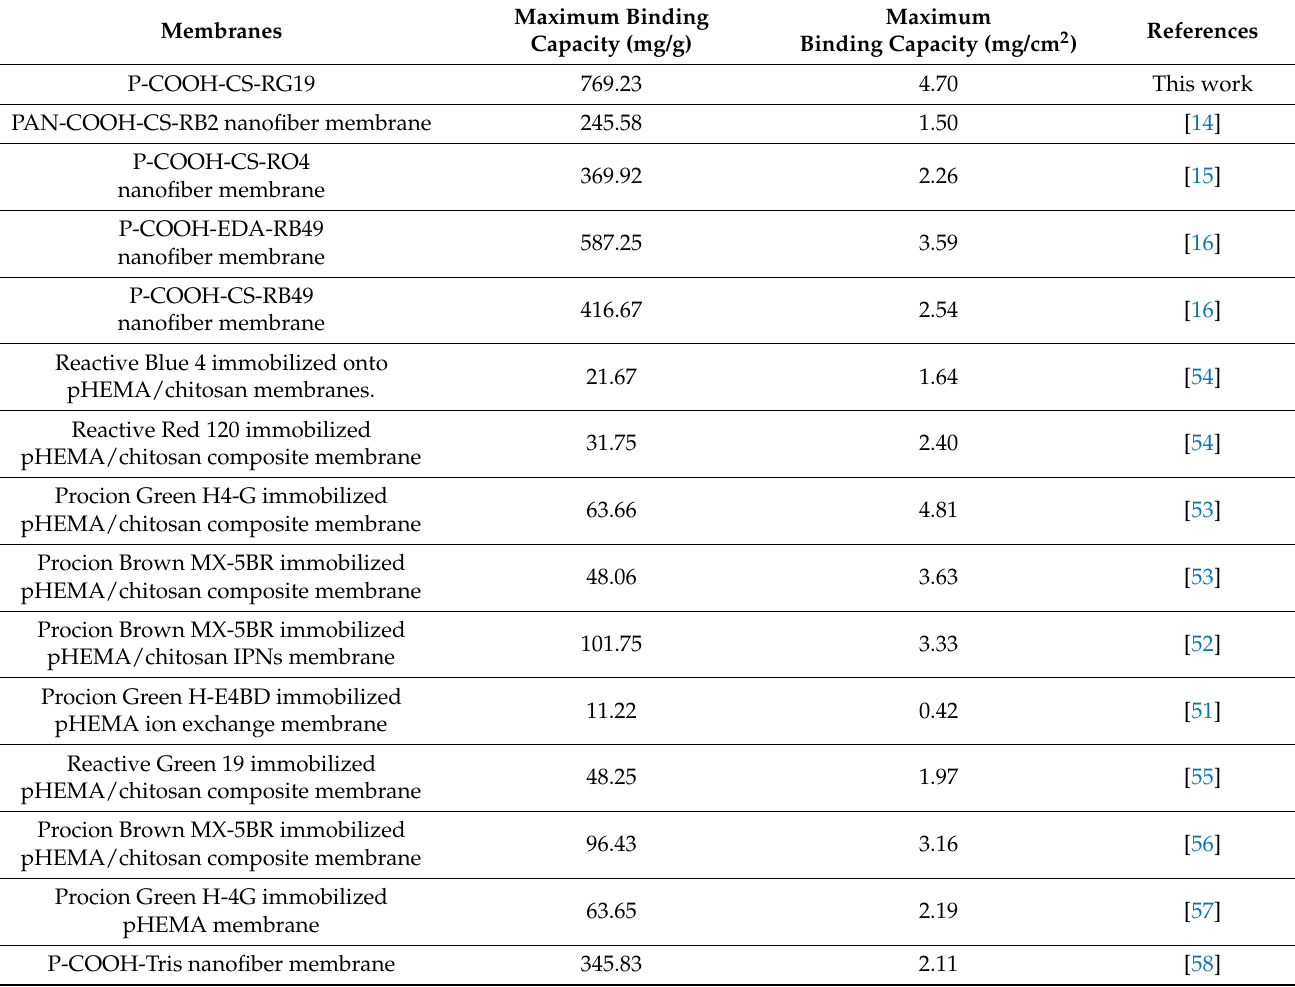
Table 6. Comparison with conventional membranes for adsorption capacity of pure lysozyme.